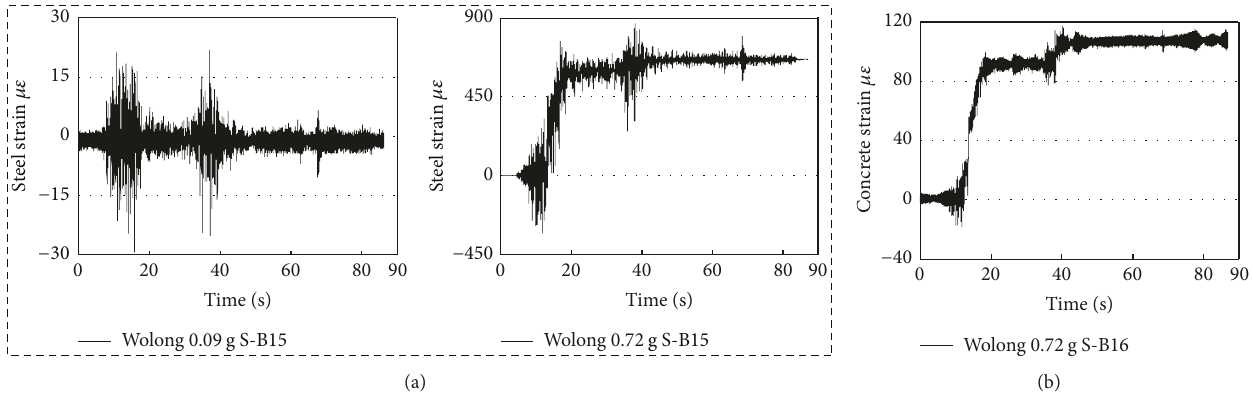
Figure 17: Strain time histories of the rebar and concrete under Wolong record input: (a) rebar and (b) concrete. Table 7: Peak tensile strain of latticed concrete infill walls ( 𝜇𝜀 ).